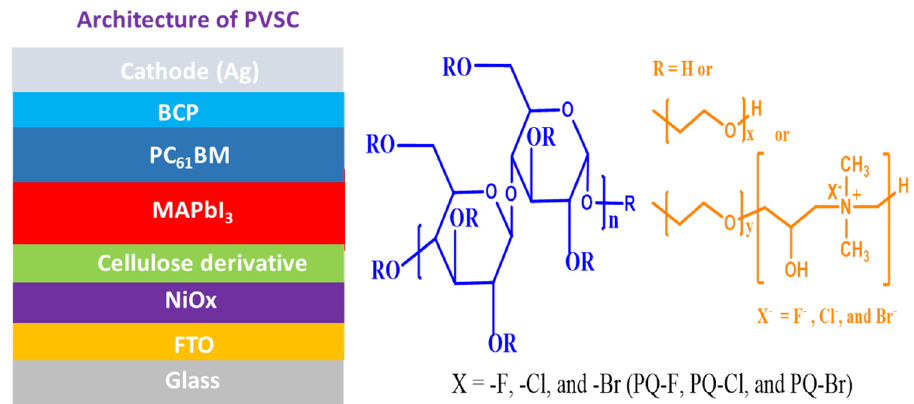
Figure 1. Chemical structures of the cellulose derivatives PQF, PQCl, and PQBr and architecture of the PVSCs incorporating the cellulose derivative–modified NiO x films.